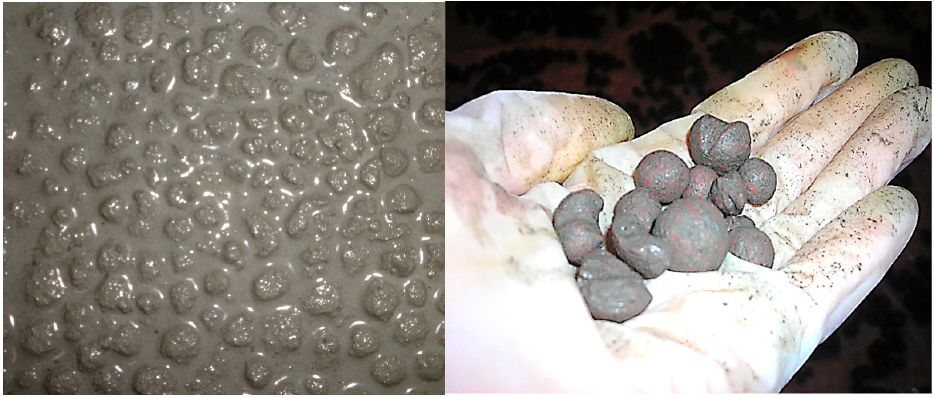
Figure 2. LWA immersed in cement paste (Lytag) and separated from the mixture (Liapor). Table 4. Description of impregnated and non-impregnated LWAs used in the research.